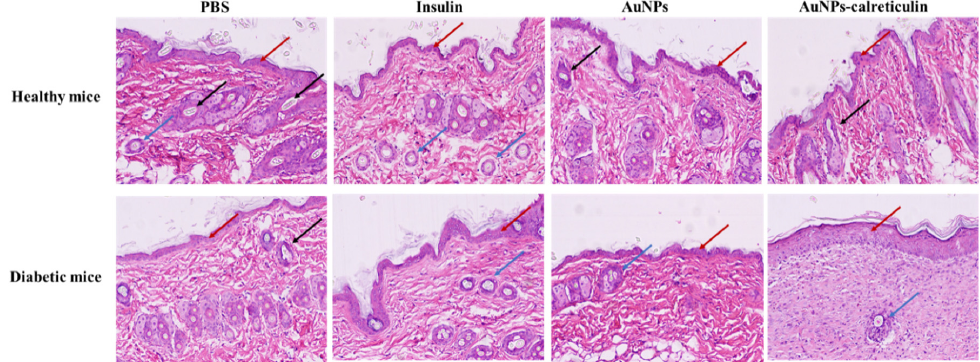
Figure 11. Hematoxylin and eosin (H&E) staining after full thickness skin incision performed. Skin tissue of healthy and diabetic mice at 15 days after surgery. The red arrows indicate epidermal proliferation, black arrows indicate hair follicle formation, and blue arrows indicate new blood vessels (pictures magnification: 10 ×